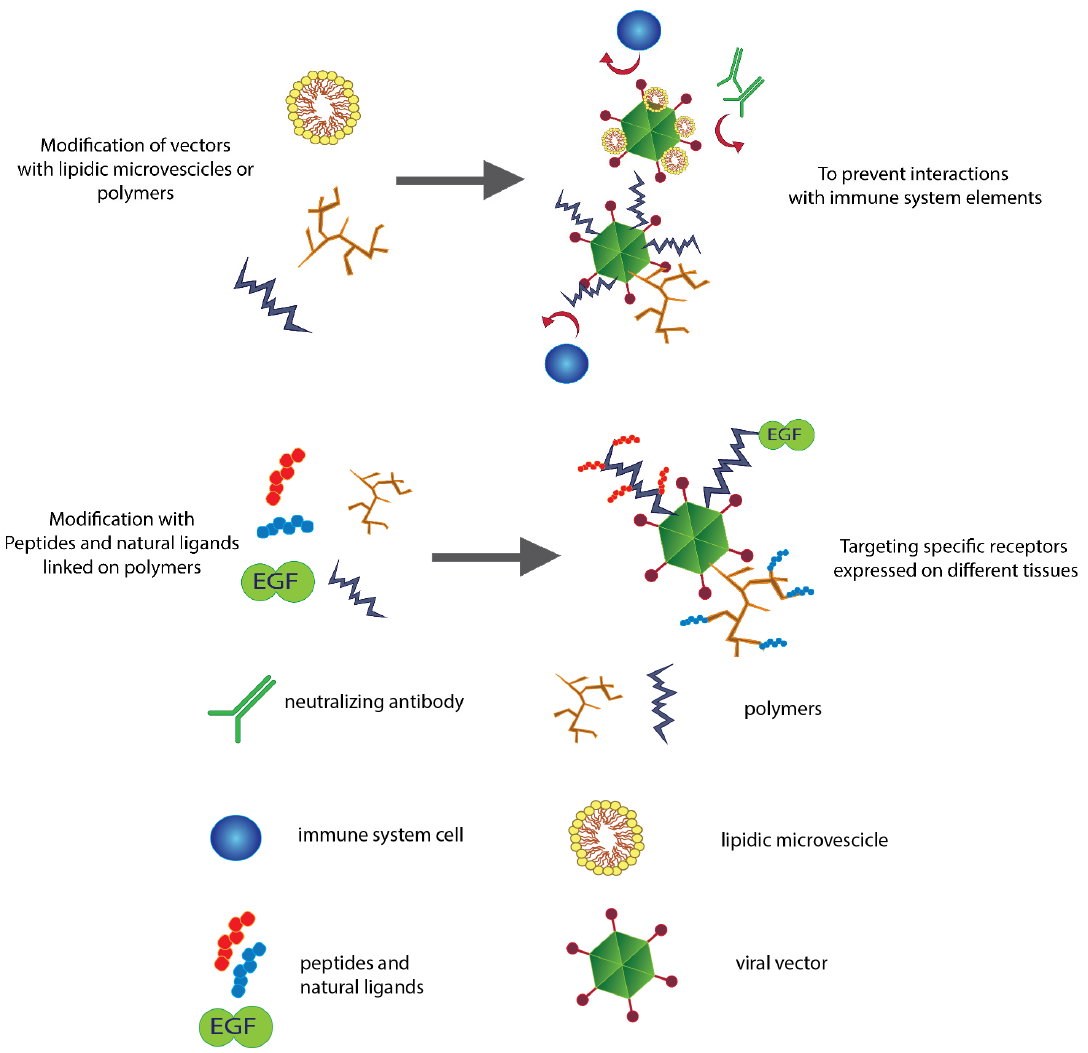
Figure 1. Modifying the surfaces of viral vectors for different purposes. Shielding viral vectors with polymers and lipidic vesicles typically results in the reduced immunogenicity and increased persistence of the vectors in the blood stream. Biomaterials and polymers represent a physical barrier that not only prevents neutralization from antibodies but also impairs the uptake of the vector by macrophages and antigen presenting cells (APC). Polymers can also be linked with peptides and ligands that target a specific receptor, changing the vector tropism and allowing efficient